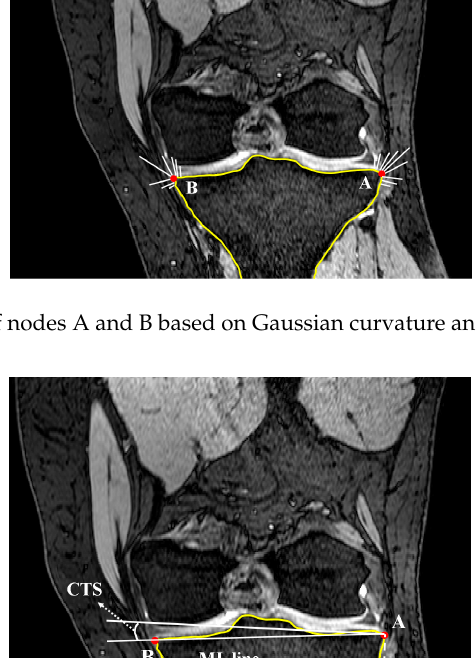
Figure 10. Definition of nodes placed on the concavity in a sagittal slide (dotted line). Nodes A and B are defined based on curvature analysis (sagittal view).